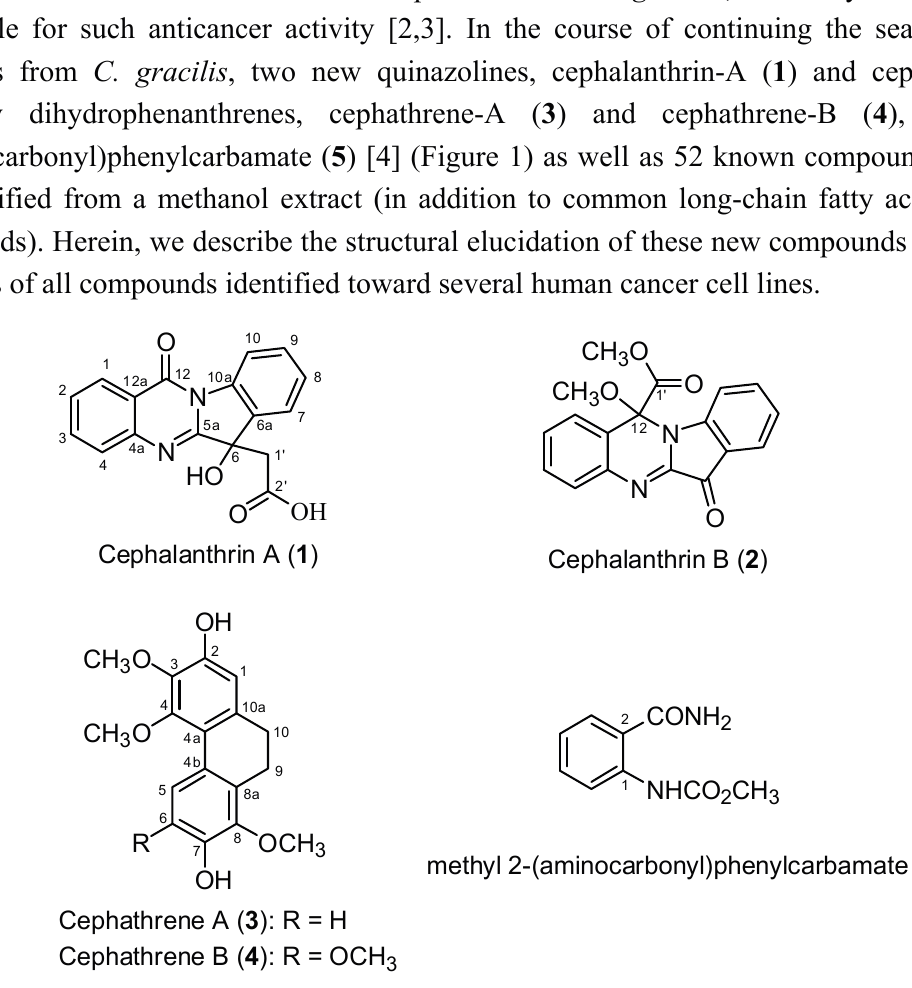
Figure 1. Structures of five new compounds 1 – 5